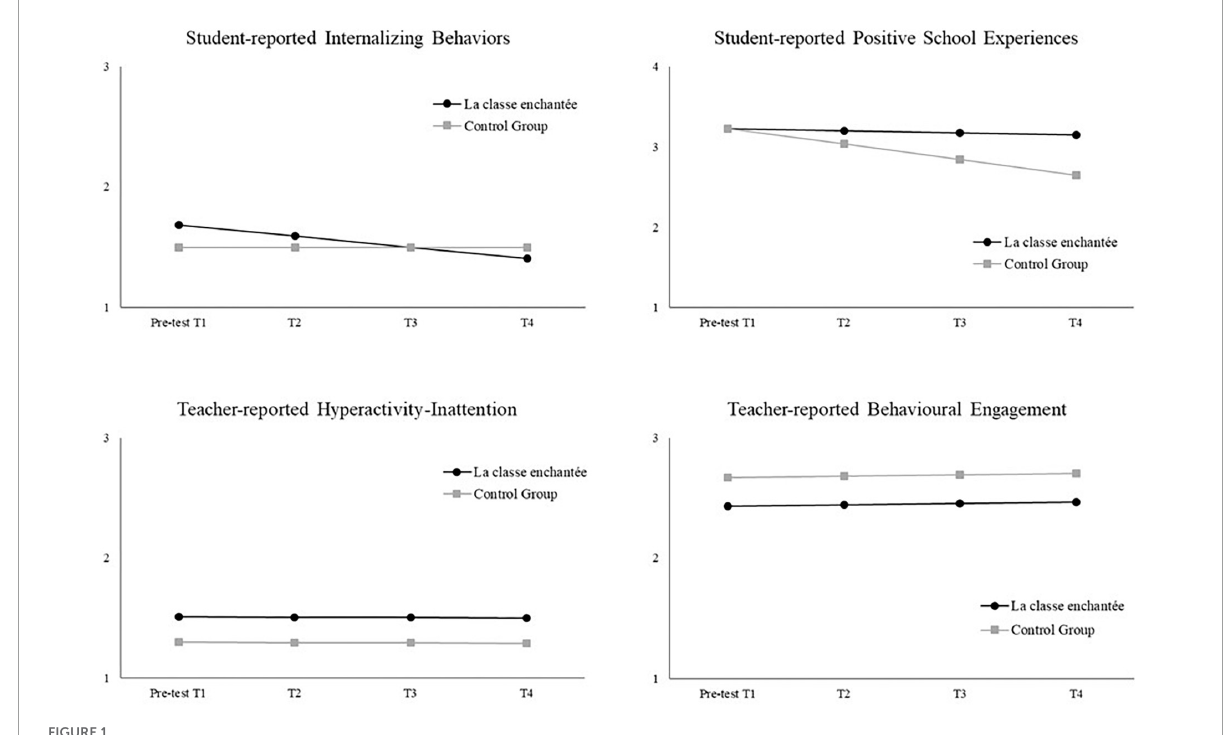
FIGURE1 Latent curve model results per